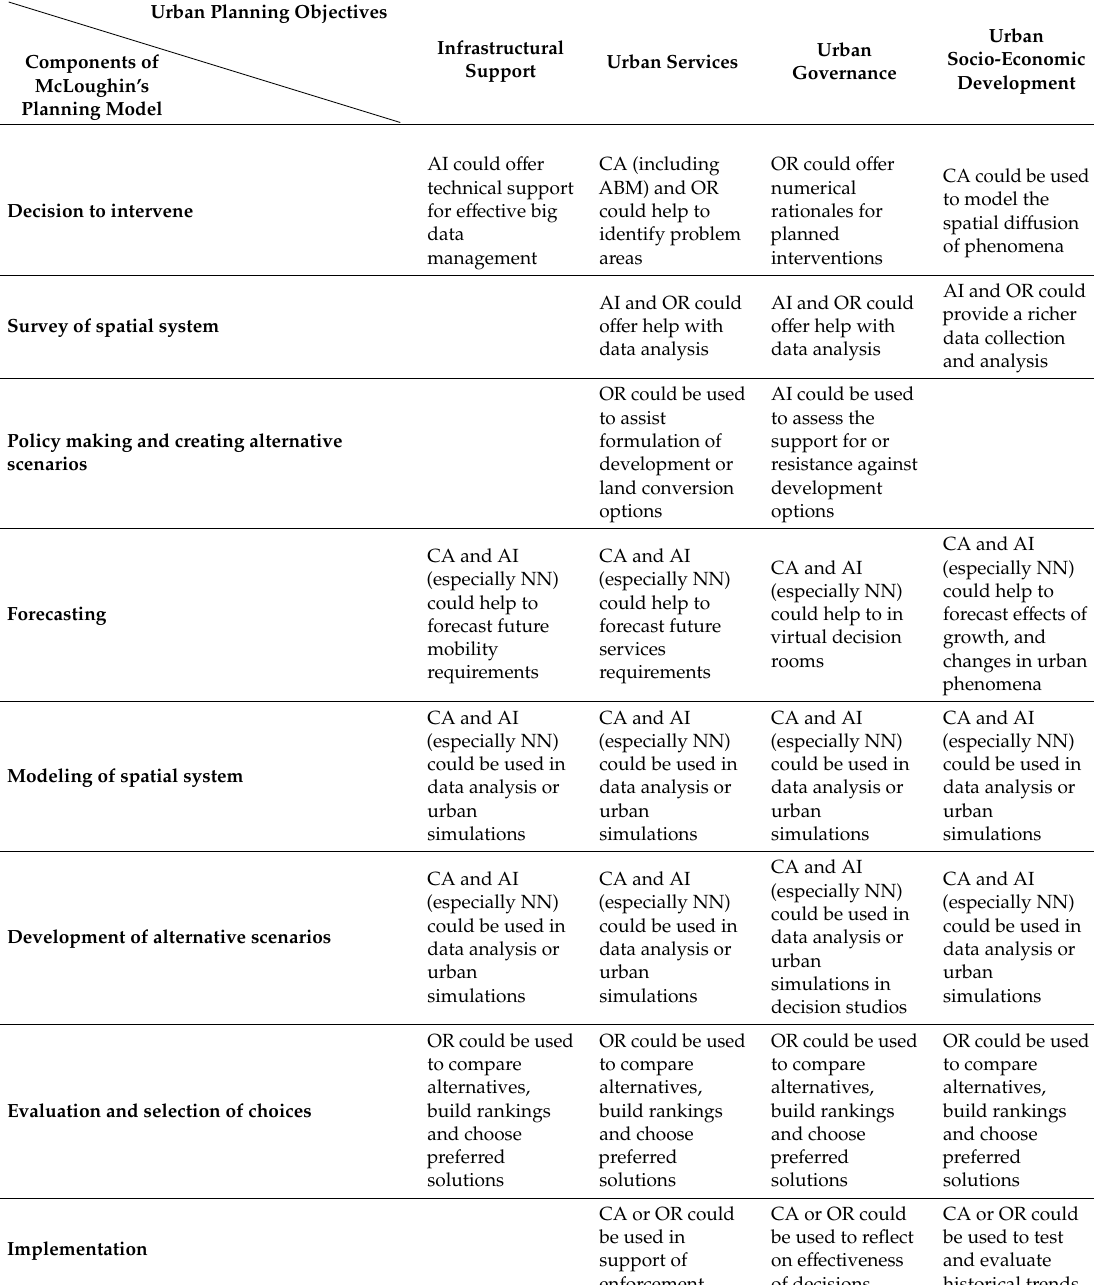
Table 2. Analytical framework to compare the usefulness and validity of the discussed